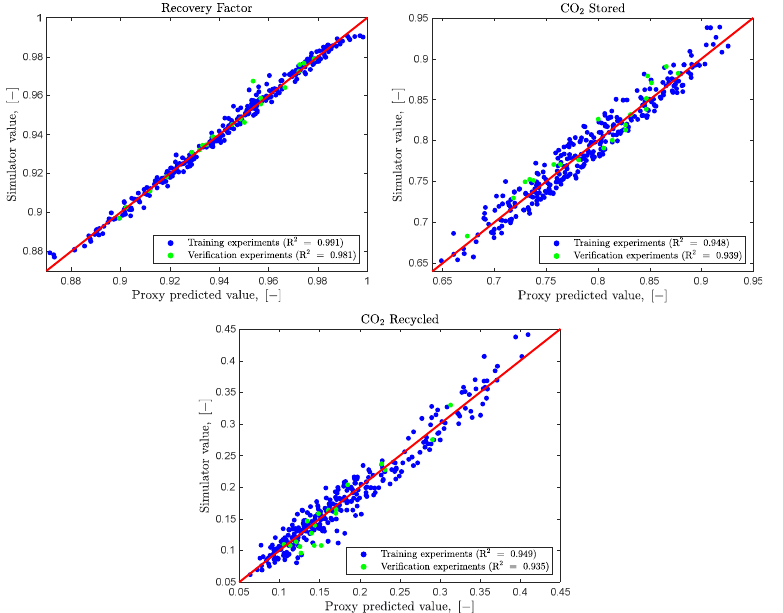
Figure 14. Polynomial proxy verification for recovery factor (top left), CO 2 stored (top right), and CO 2 recycled (bottom).